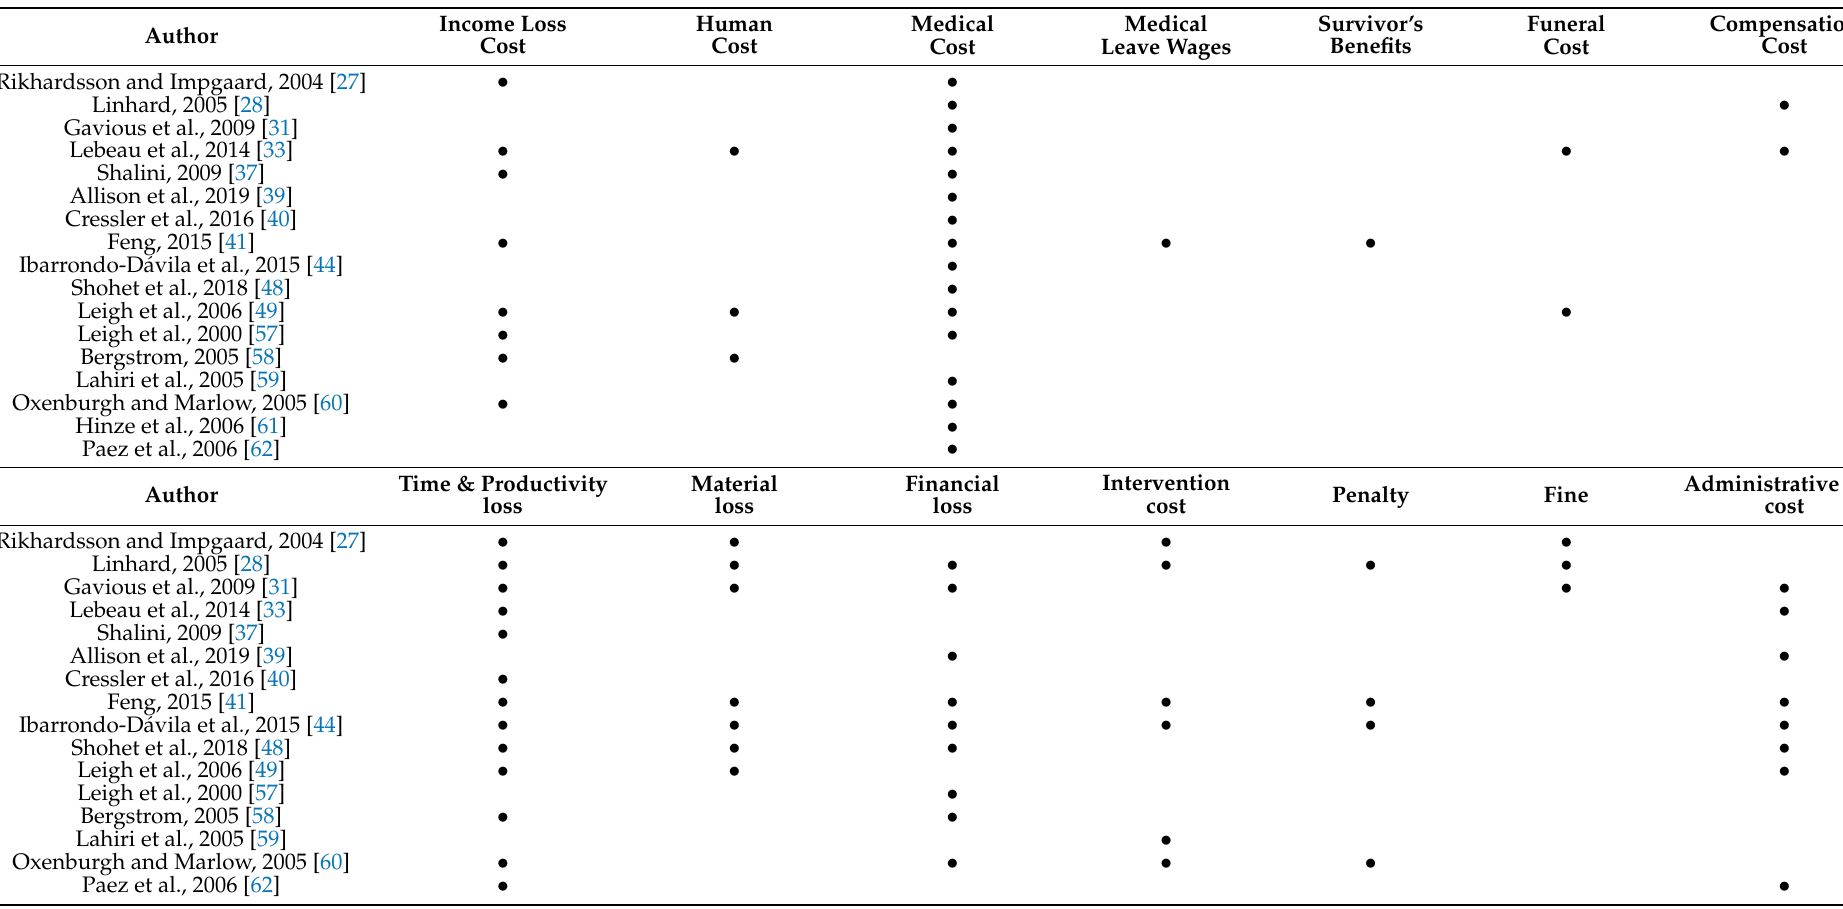
Table 5. Results of criteria selection for accident loss by reviewing previous